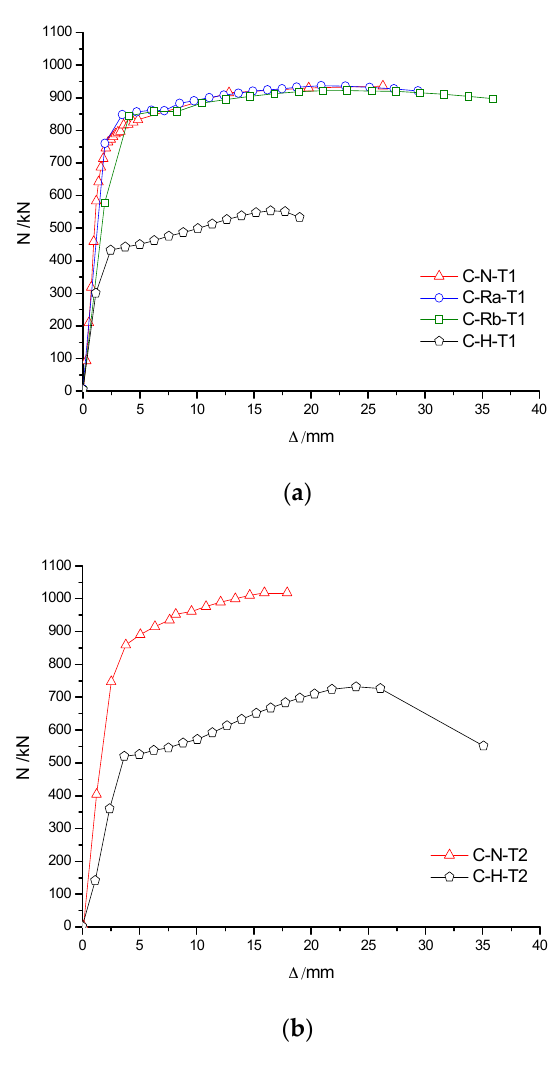
Figure 11. Influence of concrete material on N- Δ curves. ( a ) The wall thickness of the steel tube is 4 mm; ( b ) The wall thickness of the steel tube is 5 mm.